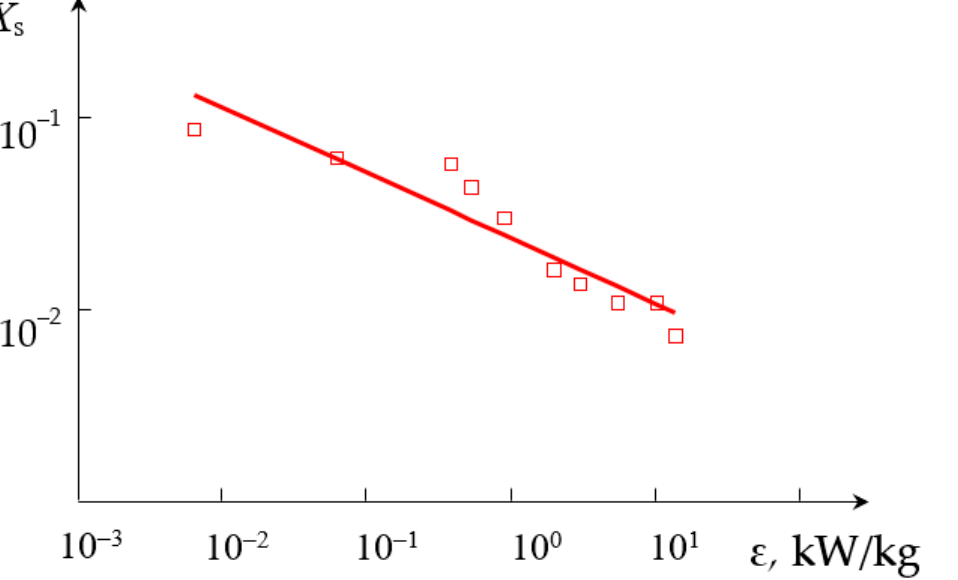
Figure 14. Dependence of the segregation index X s on the specific energy dissipation rate ε (kW/kg) for liquids supplied to the upper tangential and lower tangential branch pipes (TU1, TL2). Points—experimental data, line— X s = A 3 ε n 3 , where A 3 = 0.023, n 3 = − 0.342.